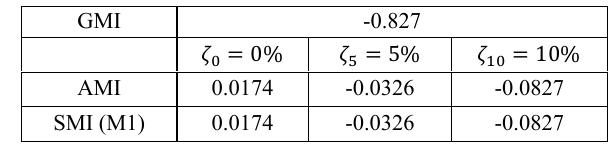
Table 2. Small-signal stability indexes for French network